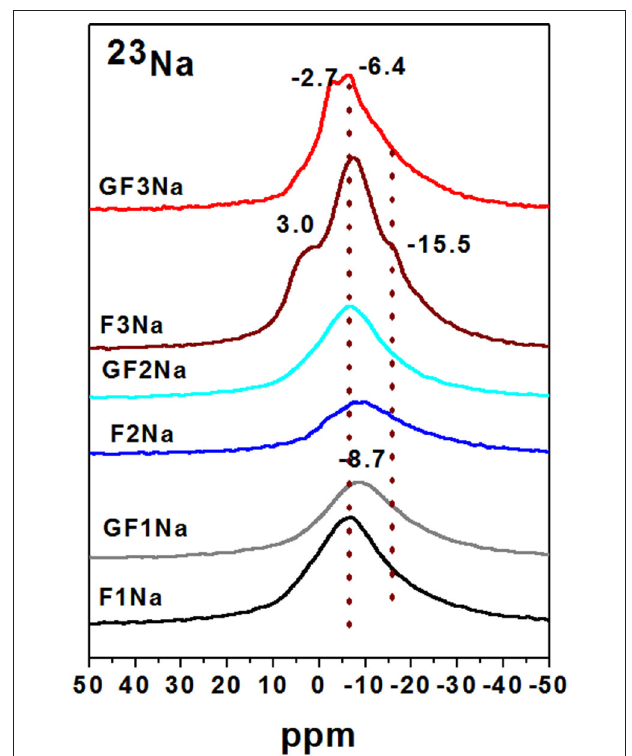
FIGURE 7 | 23 Na MAS-NMR